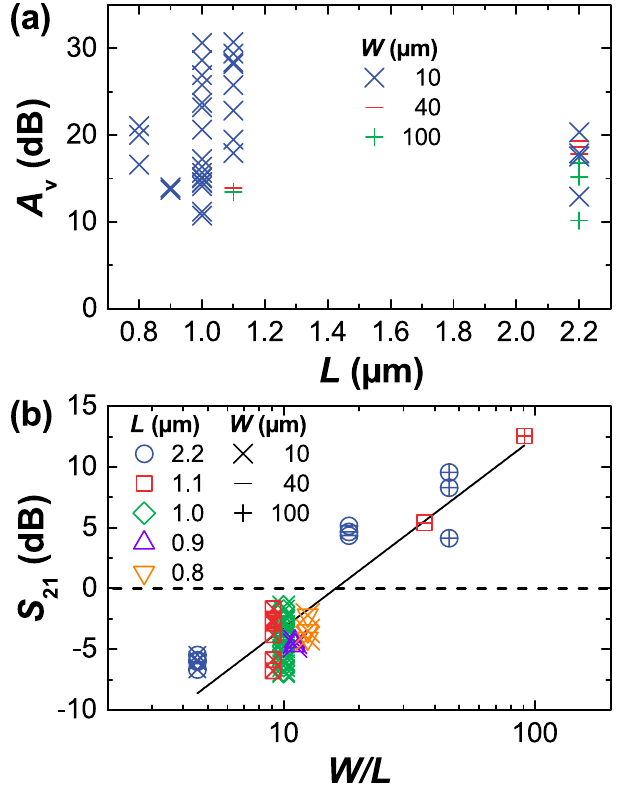
Figure 3. The highest gain in each of the fabricated GFETs at 10 MHz. ( a ) The open circuit voltage gain A function of the gate length L . ( b ) The forward gain S obtained for = W 100 μ m and = .